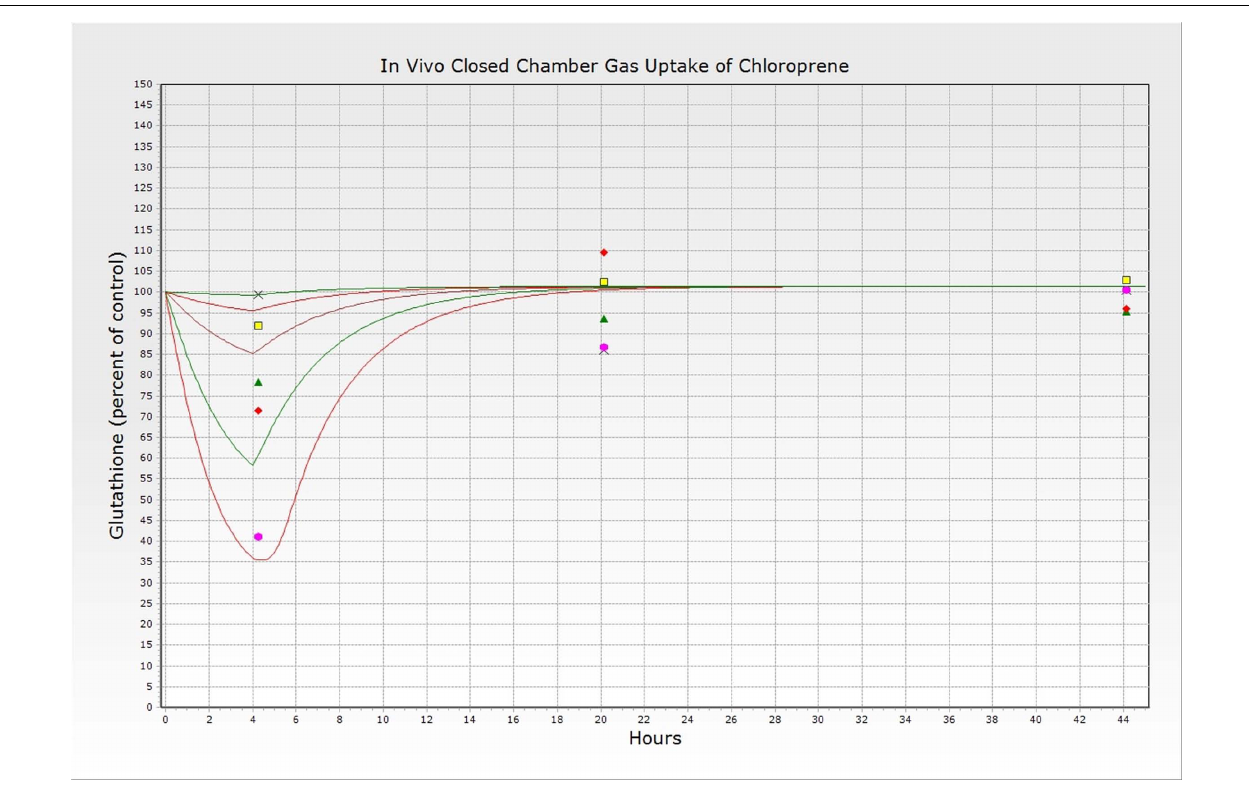
• 5760, (cid:2) 192, (cid:3) 57.6, (cid:4) 19.2, and × 5.76ppm. PBPK model